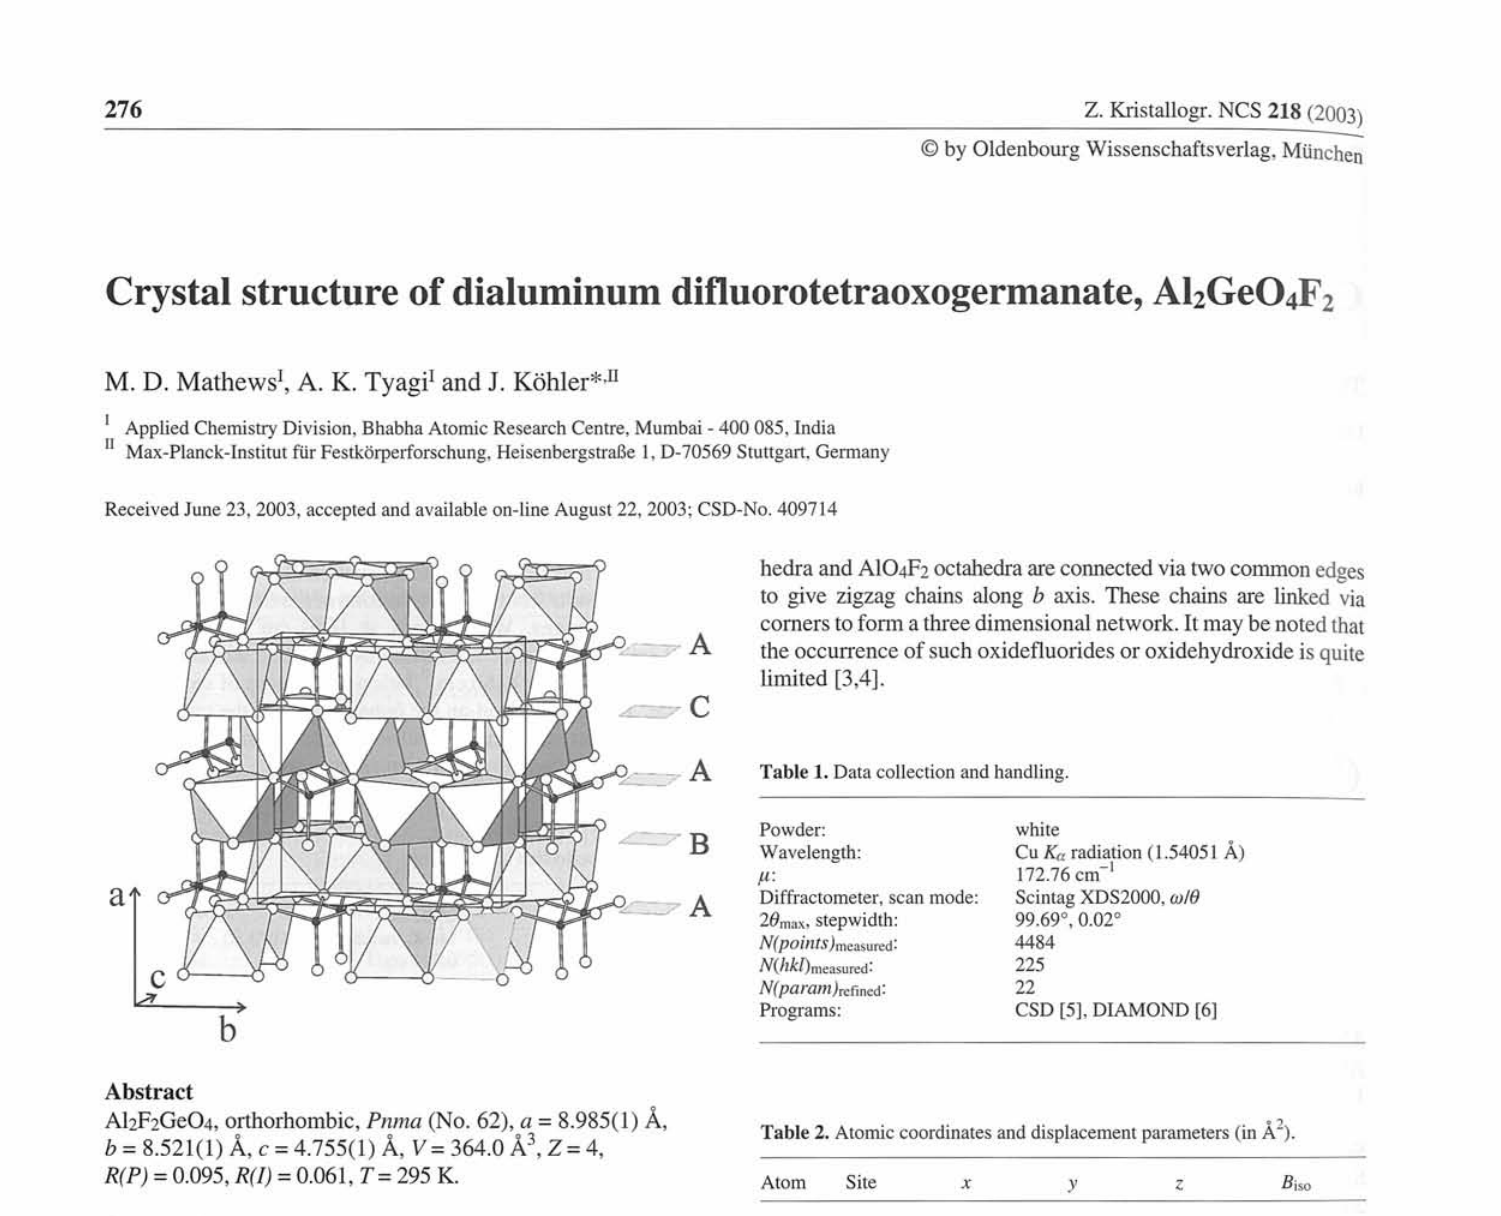
Table 2. Atomic coordinates and displacement parameters (in Â 2